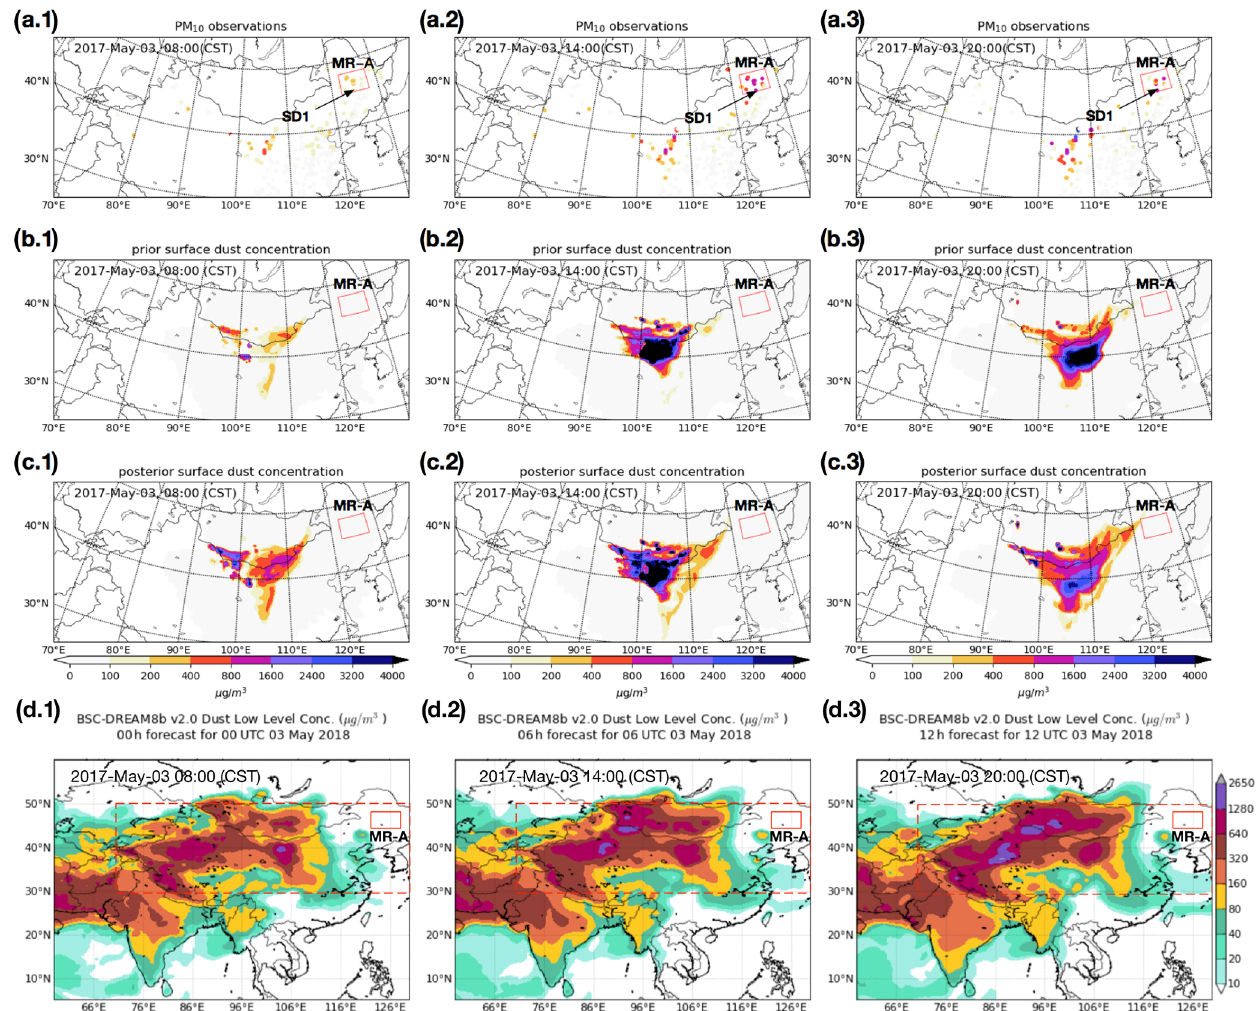
Figure 5. PM 10 observations and surface dust concentrations simulated for the first severe dust event (SD2) for 3 May, 08:00 (CST) (a.1– d.1) , 14:00 (a.2–d.2) , and 20:00 (a.3–d.3) . Top row PM 10 observations (a.1–a.3) , second row prior simulations (b.1–b.3) , third row posterior simulations (c.1–c.3) , and bottom row BSC-DREAM8b simulations (d.1–d.3) . MR-A: marked region A.